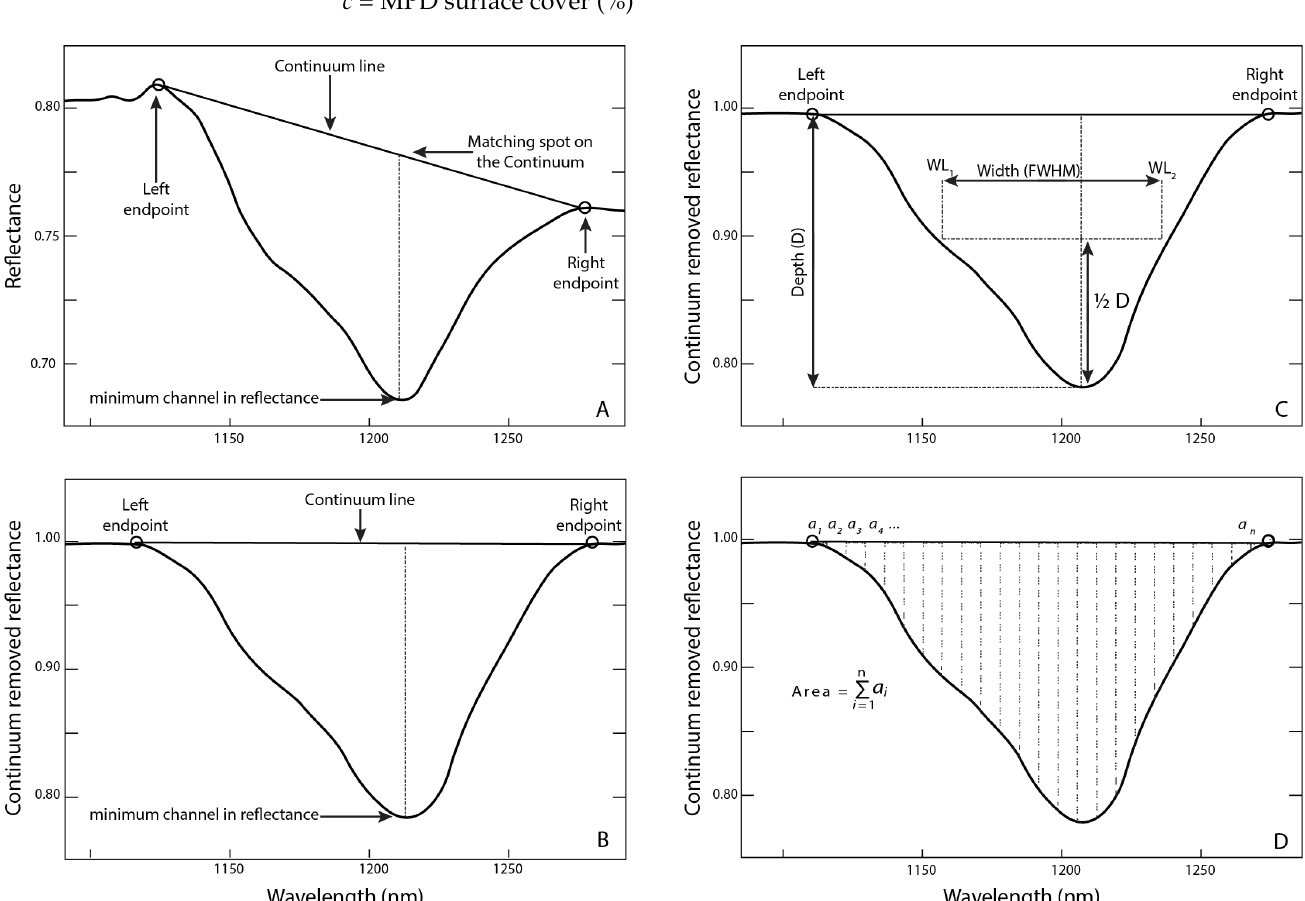
Figure 4. Spectral Feature Analysis ( A ) Continuum endpoints used to determine the continuum line for the spectral absorption feature ( B ) Continuum-hull removed spectral absorption ( C ) feature depth and feature width (full width at half-maximum as defined by Kokalay and Skidmore [51] and ( D ) feature area, calculated by summing the individual band depths of each channel within the continuum-removed spectral absorption